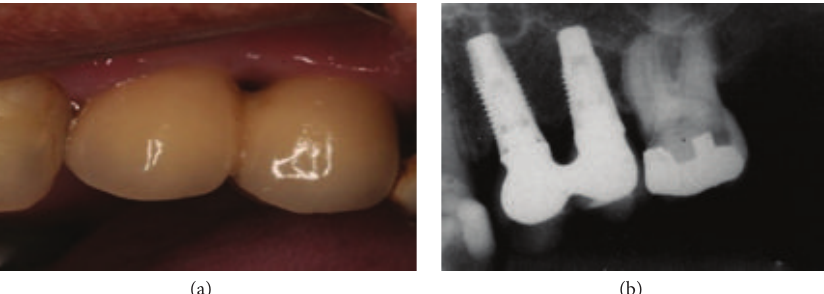
Figure 5: Six-year follow-up: clinical view of the implant-supported fixed prosthesis (a) and periapical radiograph of implants showing no bone loss (b) (May 2014).